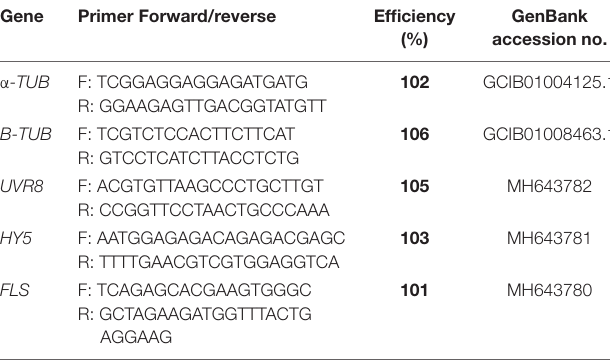
TABLE 1 | Nucleotide sequence of primers used in the RT-qPCR, efficiency and genbank